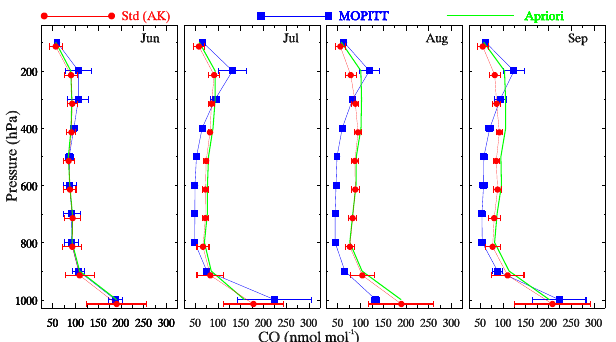
Figure 6. Comparison of monthly average CO from WRF-Chem simulations (Std) with the MOPITT retrievals over Chennai during the 4months of the summer monsoon period of the year 2008. The MOPITT averaging kernel and the a priori profile have been applied to the WRF-Chem output, denoted by Std (AK). MOPITT a priori profile is also shown for